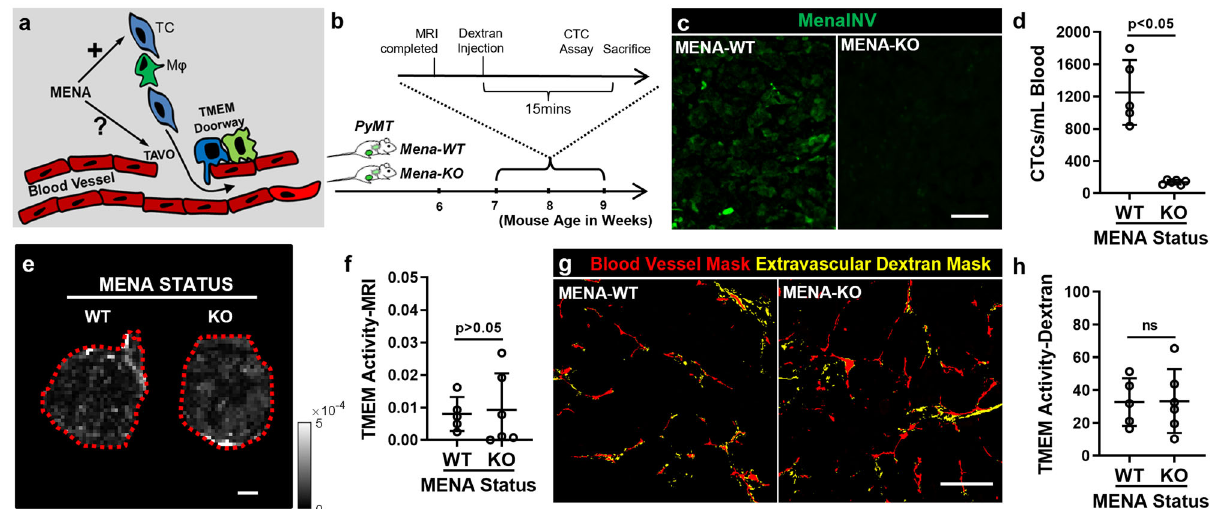
Fig. 4 TMEM activity-MRI demonstrates that MENA is not necessary for TMEM-associated vascular opening events but is essential for cancer cell dissemination. a Experimental hypothesis under investigation using the TMEM Activity-MRI assay. The illustration displays two prerequisites of metastatic dissemination: TMEM doorway [(a cell triad composed of a macrophage (green), a tumor cell (blue), and an endothelial cell (red)], and the invasive/migratory tumor cell subset migrating alongside macrophages towards underlying TMEM doorways. Although it is known from prior literature (see text for details) that MENA is necessary for inducing invasive and migratory behavior to the prometastatic tumor cells, it is not known if MENA is also necessary for TMEM-associated vascular opening (TAVO), as depicted with the question mark. b Experimental strategy and mouse cohort composition for MMTV-PyMT (MENA + / + and MENA − / − ) mice. PyMT polyoma middle-T antigen, CTC circulating tumor cell. c Representative images of MENA INV immuno fl uorescence from MENA + / + (MENA-WT) and MENA − / − (MENA-KO) MMTV-PyMT mice. Scale = 50 um. d Circulating tumor cell (CTC) counts in MENA + / + (MENA-WT) and MENA − / −